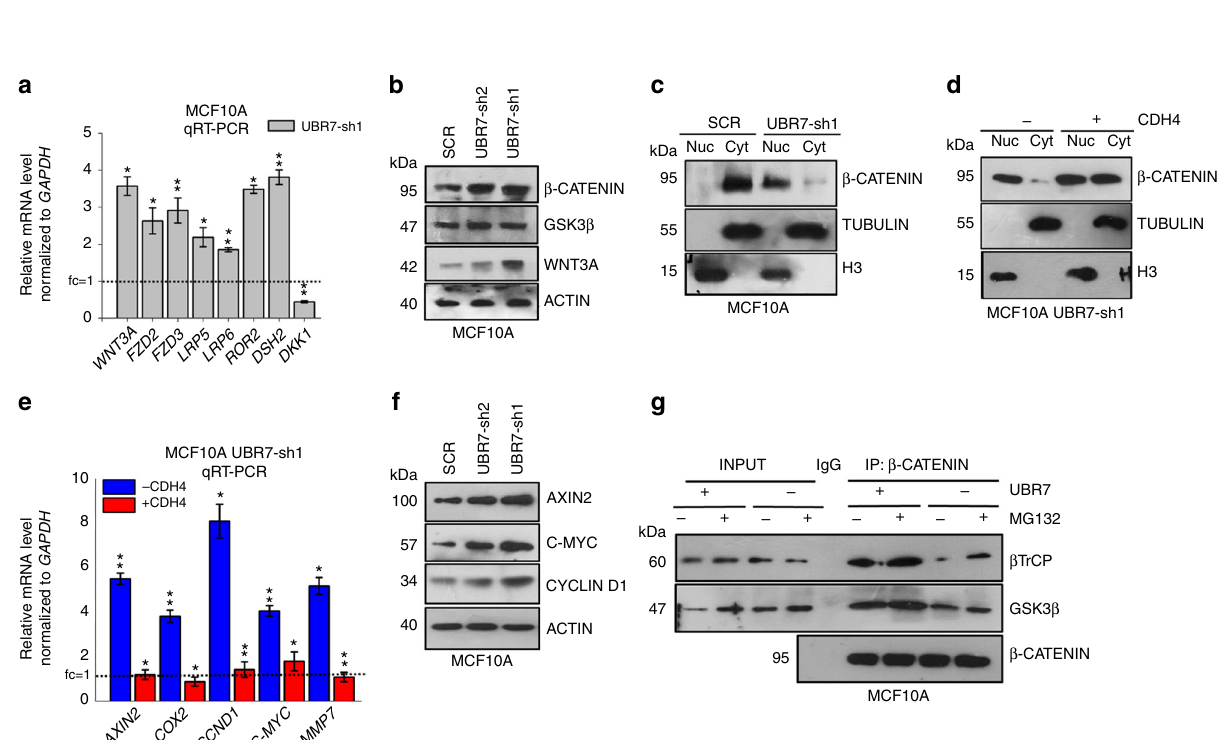
Fig. 7 UBR7 silencing activates the Wnt/ β -catenin signaling pathway. a Quantitative real-time PCR (qRT-PCR) analysis of key regulators of the Wnt/ β - catenin signaling pathway upon loss of UBR7 (UBR7-sh1). b Immunoblots monitoring expression of β -CATENIN, glycogen synthase kinase 3 β (GSK3 β ), WNT3A, and ACTIN (loading control) in MCF10A cells expressing scrambled (SCR) or UBR7-shRNAs. c Immunoblots monitoring expression of β - CATENIN in the nuclear and cytoplasmic fractions of MCF10A cells expressing scrambled (SCR) or UBR7-sh1shRNA. Histone H3 and TUBULIN were used as loading controls for nuclear and cytoplasmic lysates, respectively. d Immunoblots monitoring expression of β -CATENIN in the nuclear and cytoplasmic fractions of CDH4- expressing MCF10A UBR7-sh1 cells. Histone H3 and TUBULIN were used as loading controls for nuclear and cytoplasmic lysates, respectively. e qRT-PCR analysis of β -catenin target genes expression in UBR7-sh1 MCF10A cells upon CDH4 overexpression. f Immunoblots showing expression of β -catenin target genes upon UBR7 knockdown (UBR7-sh1 or -sh2) in MCF10A cells. g Co-immunoprecipitation of β -catenin from UBR7- containing protein ( β -TrCP). In a , e , error bars indicate standard deviation (s.d.); n = 3 technical replicates of a representative experiment (out of